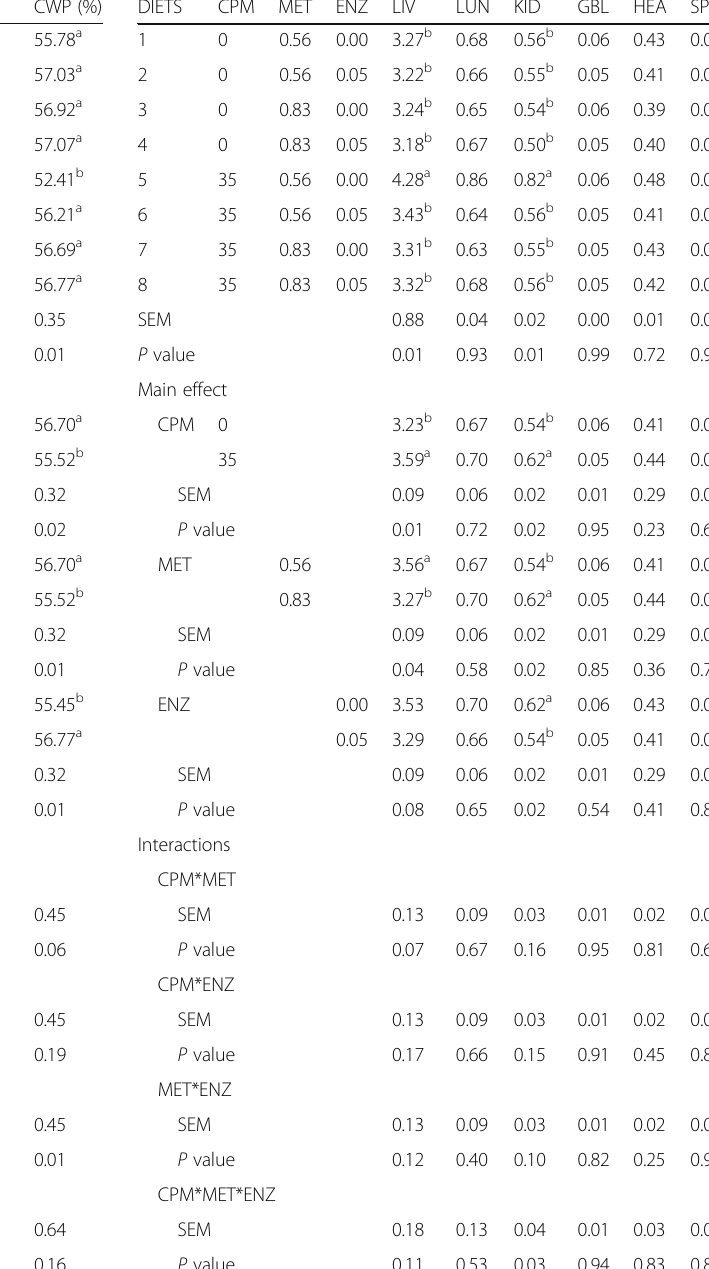
Table 5 Effect of cassava peel meal inclusion (%), methionine (%) and multi-enzyme (%) supplementation on the carcass of rabbits